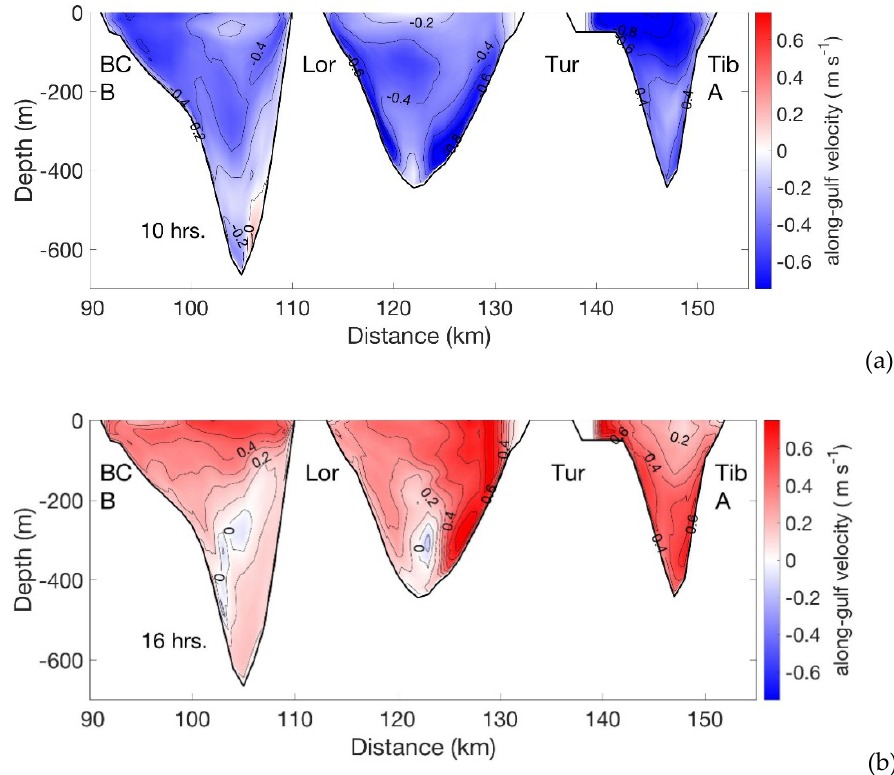
Figure 5. Depth Sections of the along‐gulf component of velocity in the line along the transect A-B (see Figure 2a) for (a) inflow and (b) outflow.